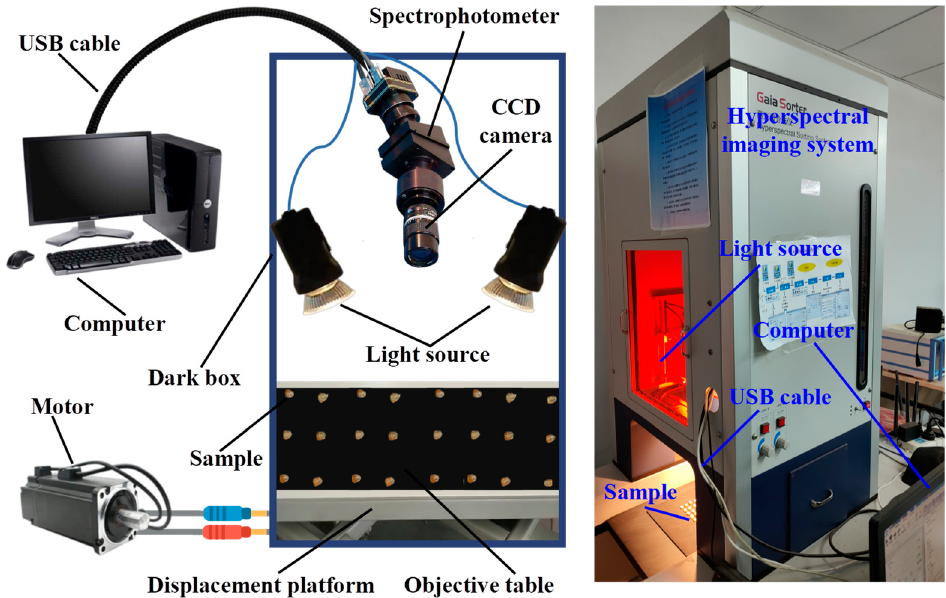
Figure 2. Hyperspectral image acquisition system.